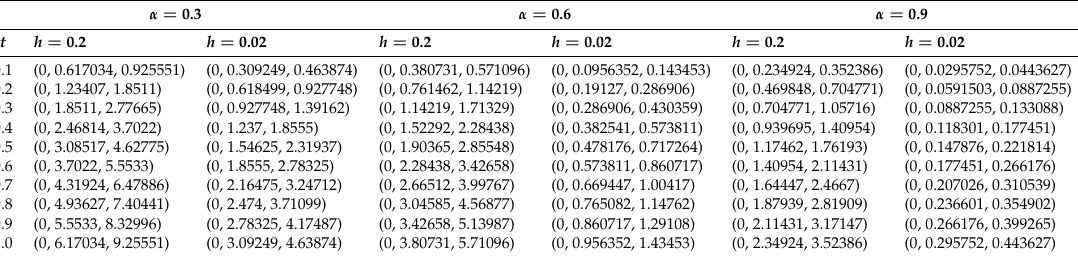
Figure 1. ( a ) The exact solution ( b ) the Caputo gH-derivative of solution defined in Example 1 for α = 0.6. Table 1. Numerical results of Example 1 for various t , α and h